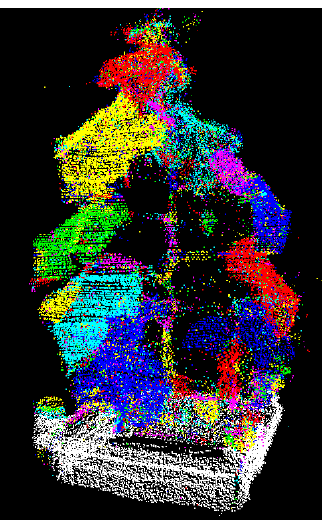
Figure 5. Oversegmented point cloud as a result of using the algorithm proposed in Reference [26]. The points’ affiliations to the respective segments are indicated by the